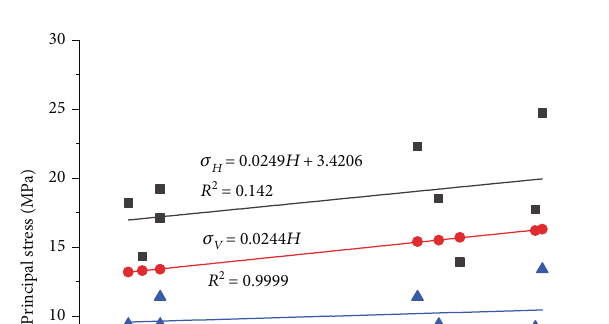
Figure 12: Fitting of the northward velocity isoline (mm/a).